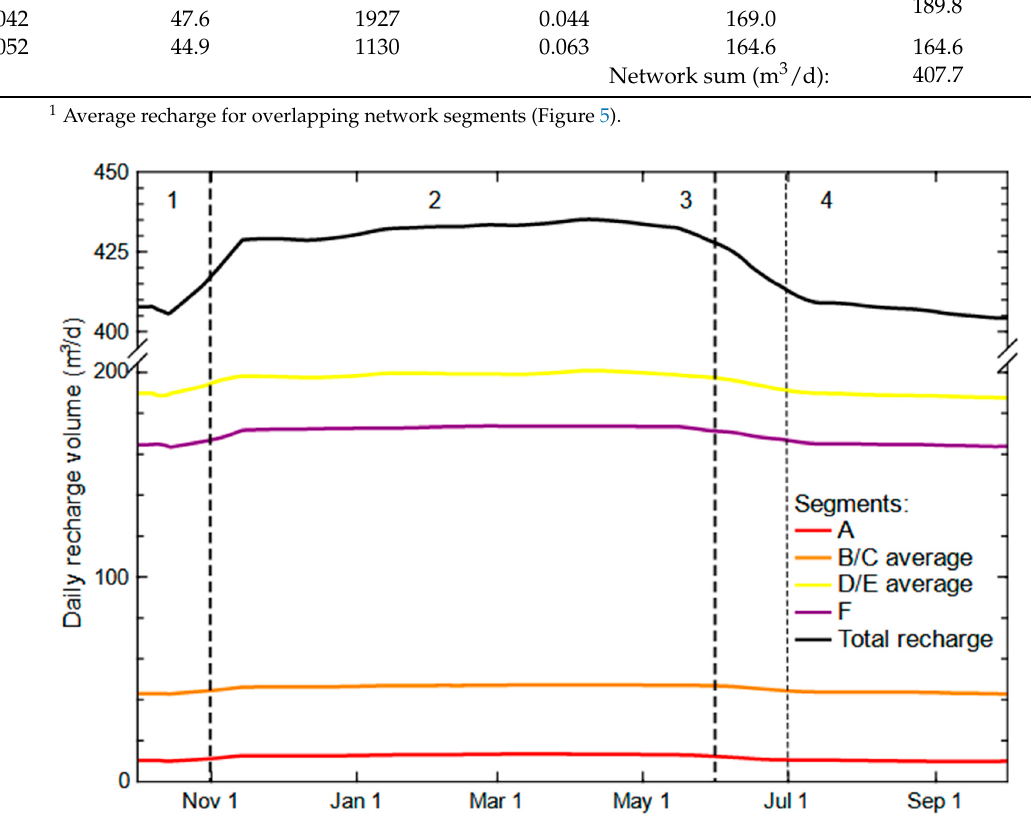
Figure 8. Daily recharge passing beneath the segments of the seismic network (Figure 5) and their summation from dv/v-derived groundwater elevations. Temporal periods (1–4) were seasonal divisions used to develop correlations between dv/v and groundwater changes.